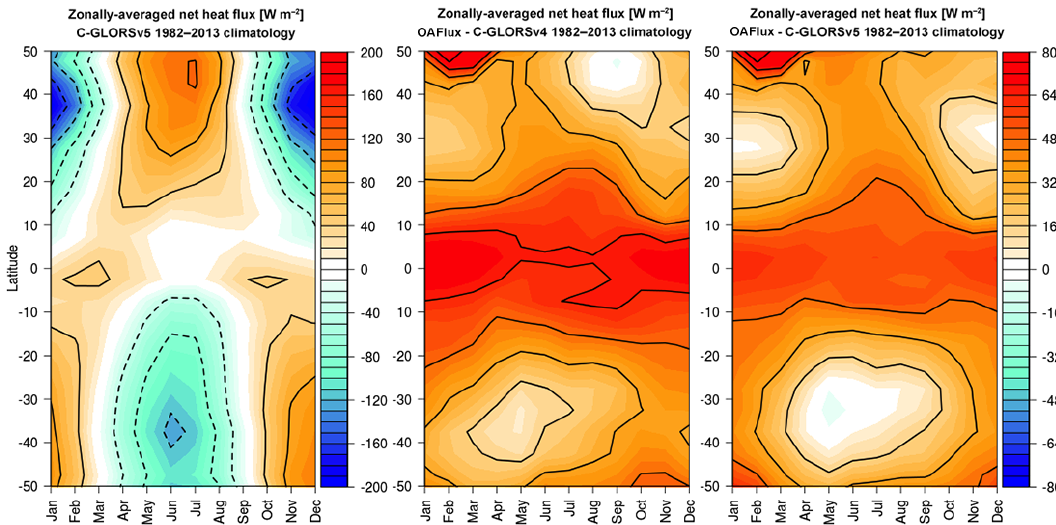
Figure 13. Zonally averaged net heat flux (downwards) climatology (1982–2013): C-GLORSv5 (left panel), difference between OAFlux and C-GLORSv4 (middle panel) and difference between OAFlux and C-GLORSv5 (right